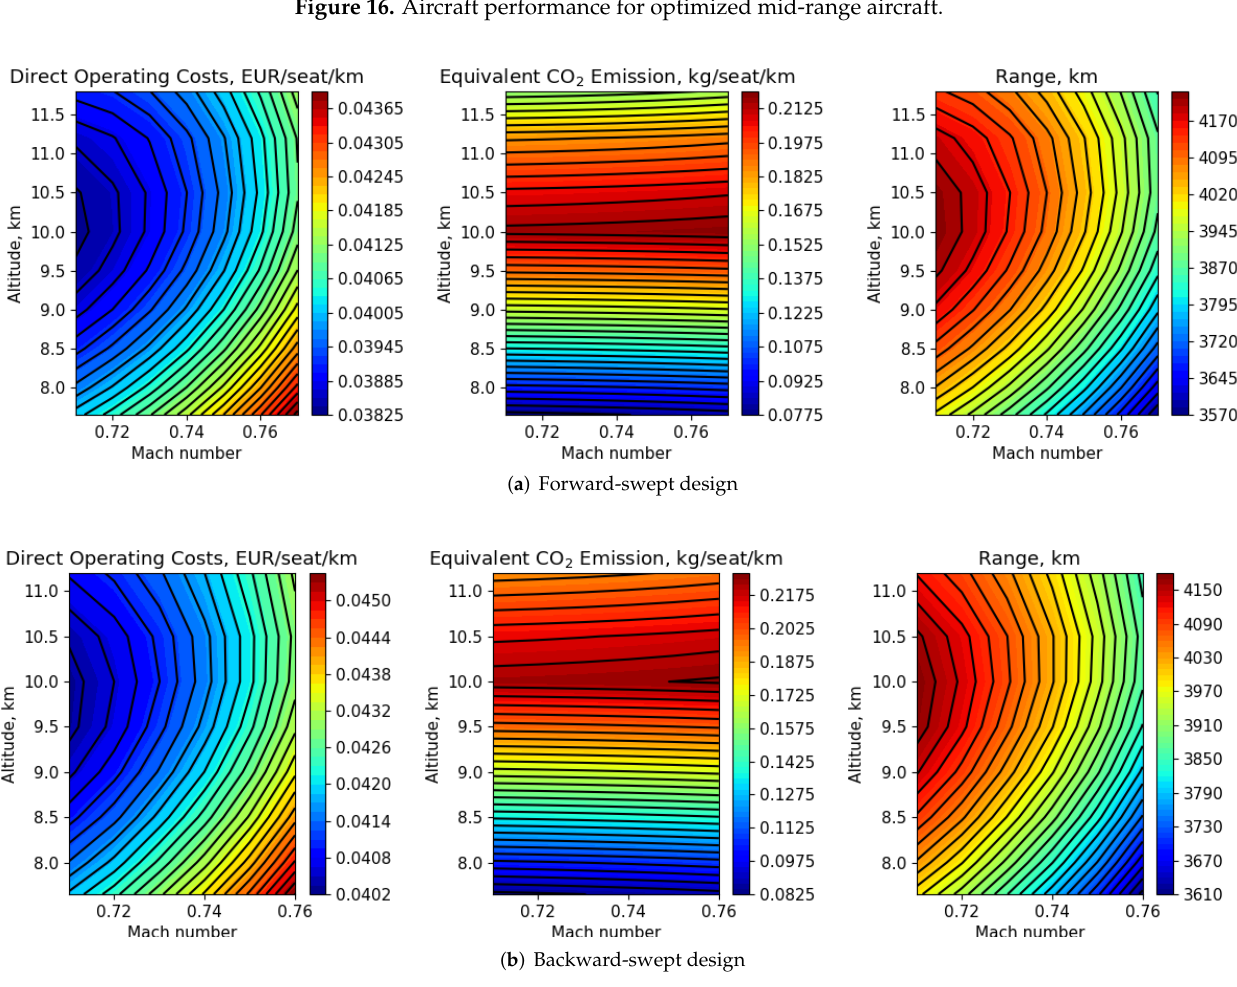
Figure 17. Emission, DOC, and range sensitivities to cruise Mach number and